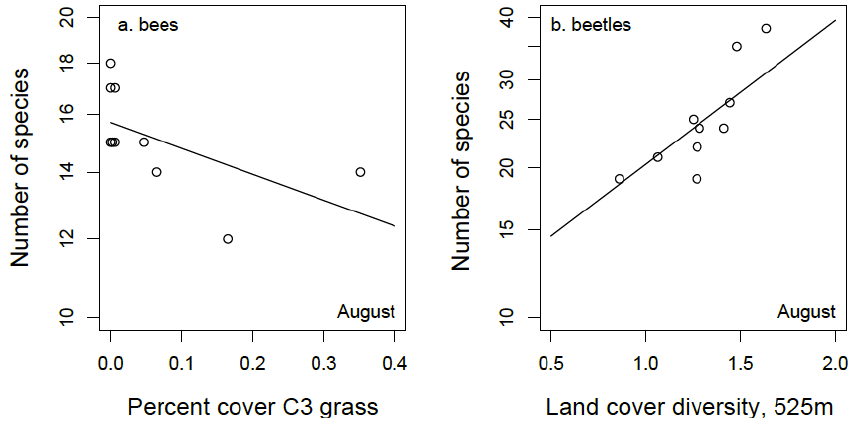
Figure 4. ( a ) Relationship between bee species richness in 10 conservation grasslands during August and the proportional of C3 grasses within grassland patches; ( b ) Relationship between beetle species richness and land cover diversity in a 525 m radius surrounding grassland